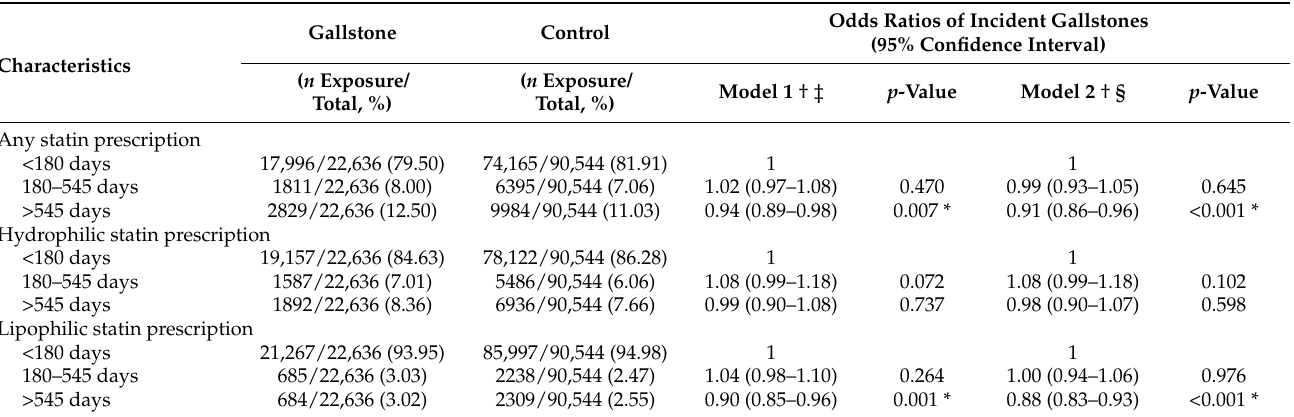
Table 2. Crude and overlap propensity-score-weighted odds ratios of incident gallstones according to statin type and duration of statin